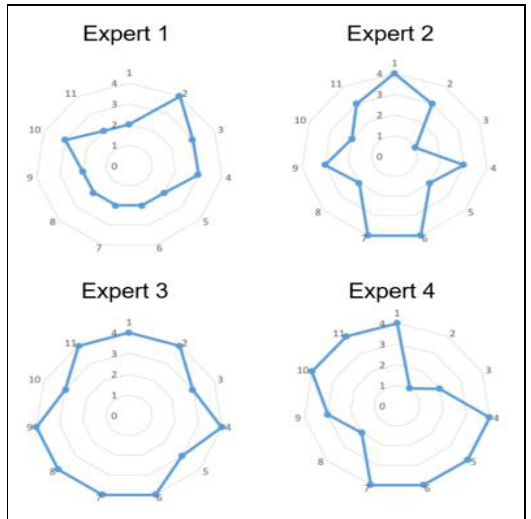
e ff ectiveness, e ffi ciency, flow, engagement, satisfaction, and preference.